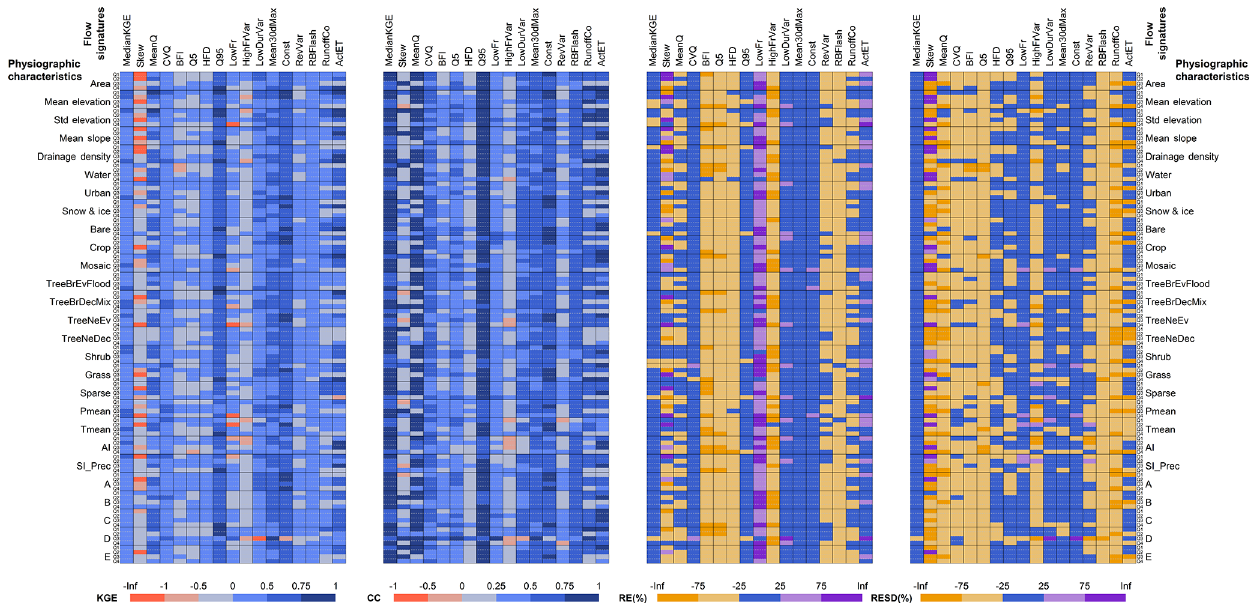
Figure 7. Matrix showing the relation between model capacity to capture flow signatures (colours, where blue is good and yellow/red/purple is poor performance) and physiography of catchments, divided into quartiles (Q1–Q4) for characteristics of the total area upstream of each gauging station with more than 10 years of continuous data (5338 catchments). Descriptions of flow signatures and physiographic characteristics are found in Tables 4–5 and metrics used for model performance in Eqs.